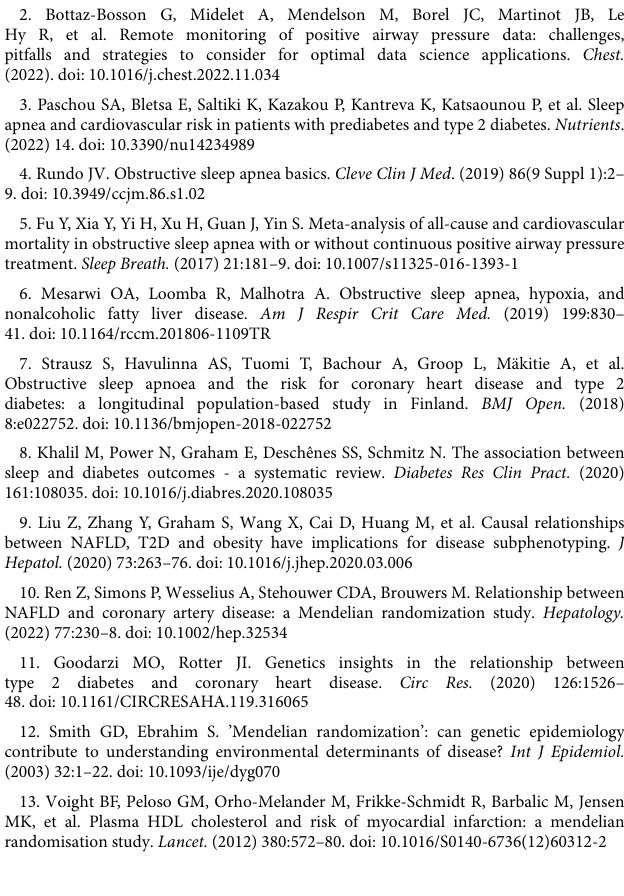
14. Bos MM, van Heemst D, Donga E, de Mutsert R, Rosendaal FR, Blauw GJ, et al. The association between habitual sleep duration and sleep quality with glycemic